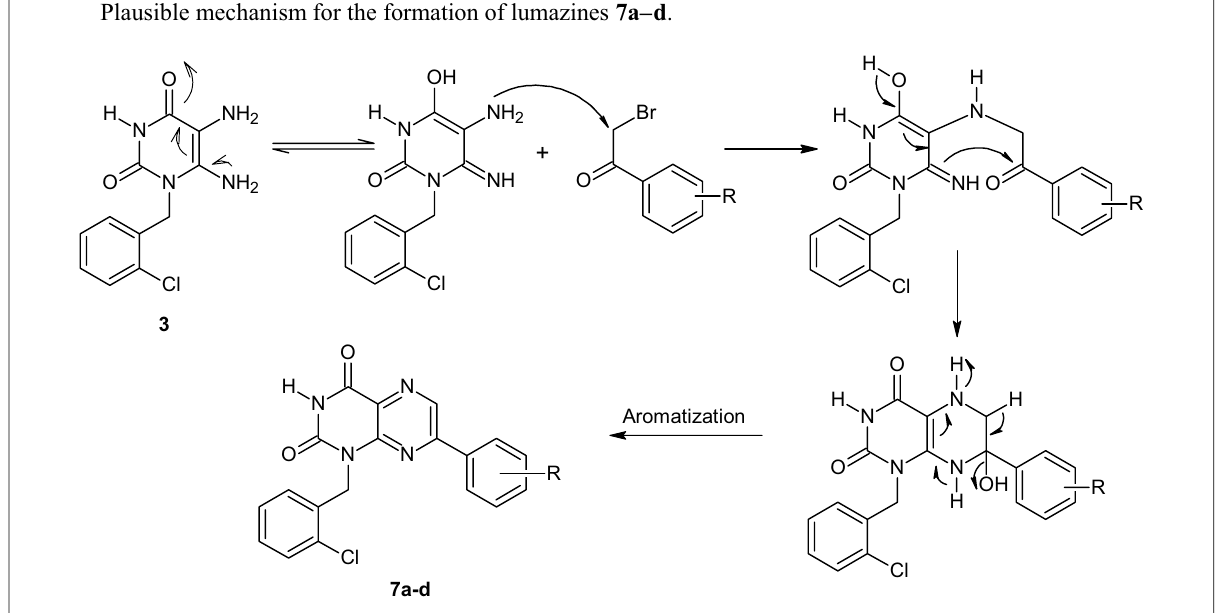
Table 1 In vitro antimicrobial activity of compounds 5